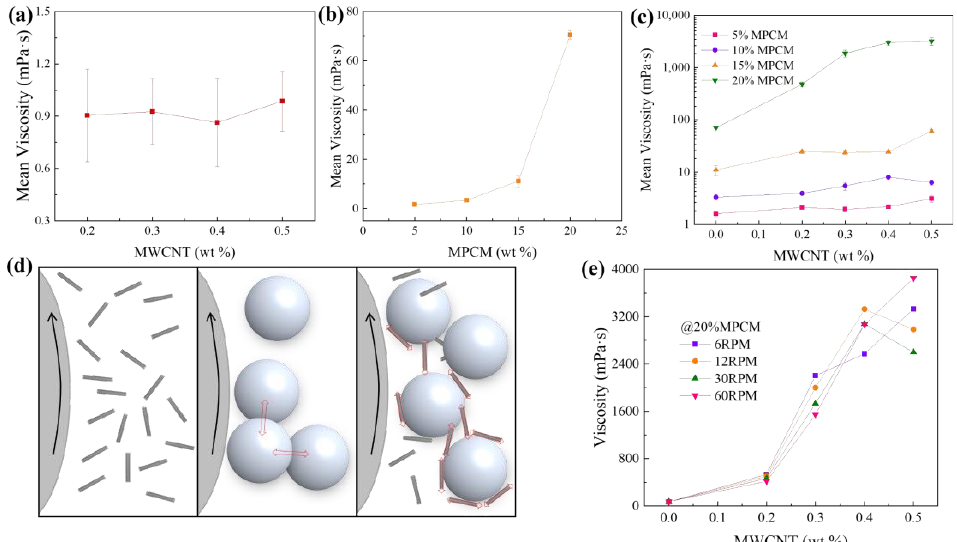
Figure 8. Mean viscosity of ( a ) MWCNT slurry, ( b ) MCPM slurry, and ( c ) MWCNT-MPCM slurry; ( d ) mechanism of increasing viscosity; ( e ) viscosity of MWCNT-MPCM in different rotational